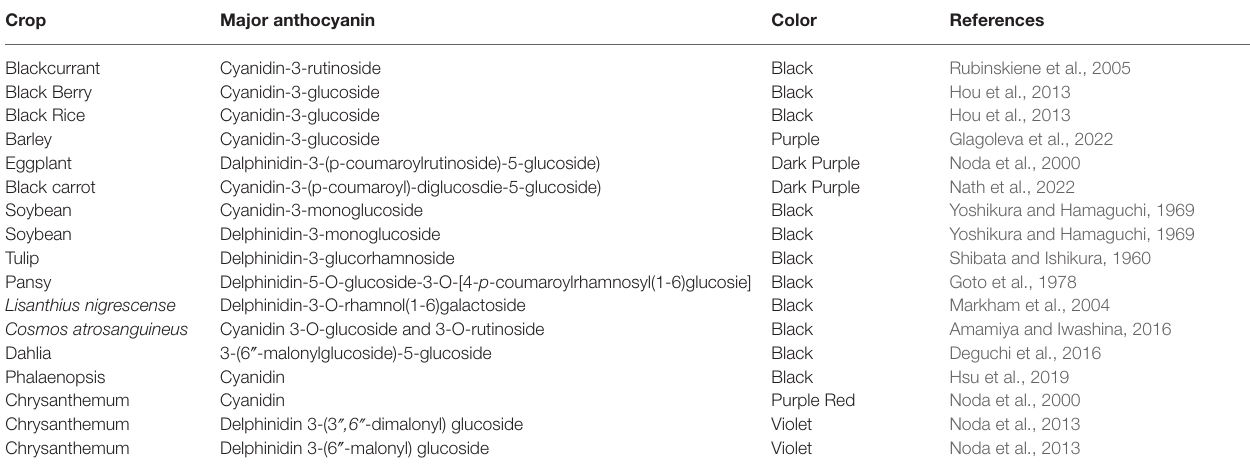
TABLE 1 | Major deep color anthocyanins in flowering and food